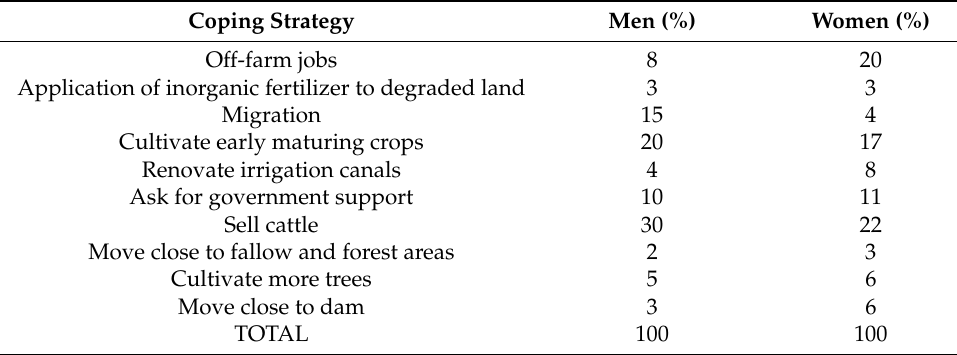
Table 1. Strategies identified from observations of the best performers of both gender groups during the grazing game (n female games = 22; n male games = 22). Strategies of Best Performers during Low Rainfall by Both Gender Group Cattle are fed on half ration The dice are thrown before a decision is taken to sell a cow Cattle are only sold in the dry season when there is shortage of feed Fertilizer is purchased to ameliorate soil fertility Herds are usually divided and sent to feed on different patches Cooperation among players to maintain a limited number of cattle